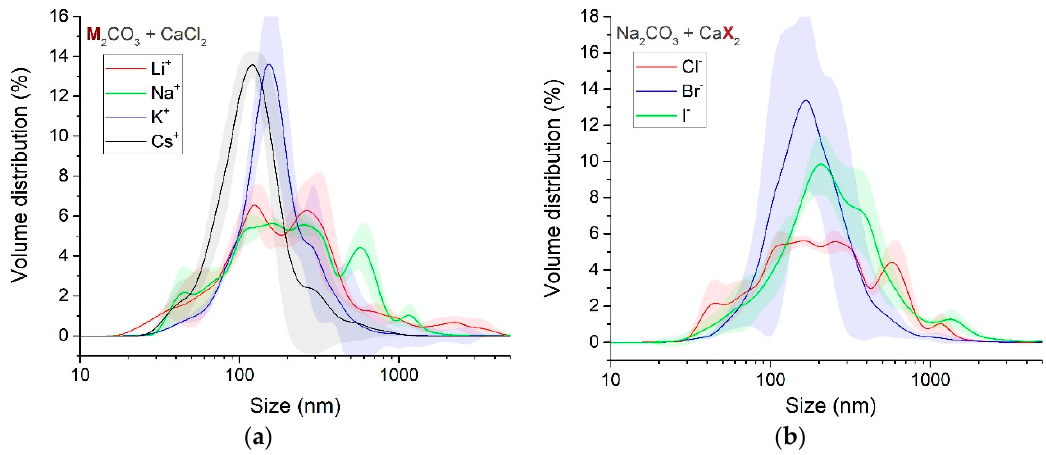
Figure 4. Particle size distribution (average of 120 consecutive measurements), expressed as volume percentage, of the precipitates during titration experiments ( a ) using different cations in the carbonate source and ( b ) using different anions in the calcium source. Shaded areas represent standard deviation from at least five titration experiments.